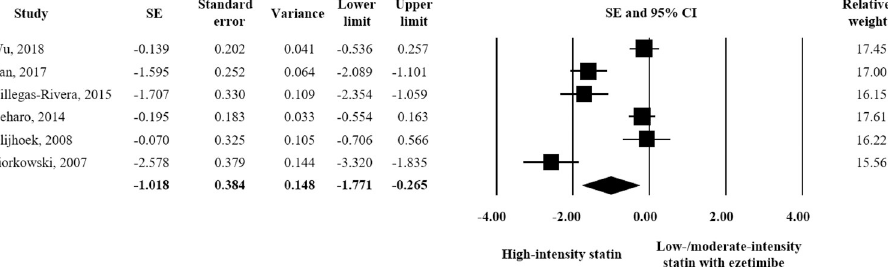
Fig 9. Forest plot of safety evaluation results. Changes in CK observed for high-intensity statin monotherapy and low/moderate-intensity statin plus ezetimibe combination